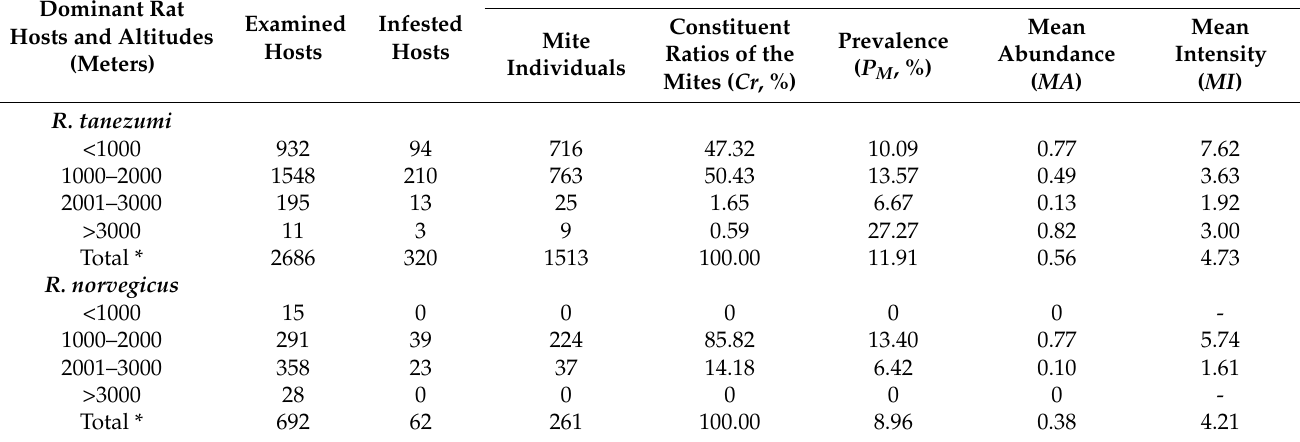
Table 6. Infestations of R. tanezumi and R. norvegicus rats with O. bacoti mites in different altitudes of Yunnan Province, Southwest China (1990–2015). Dominant